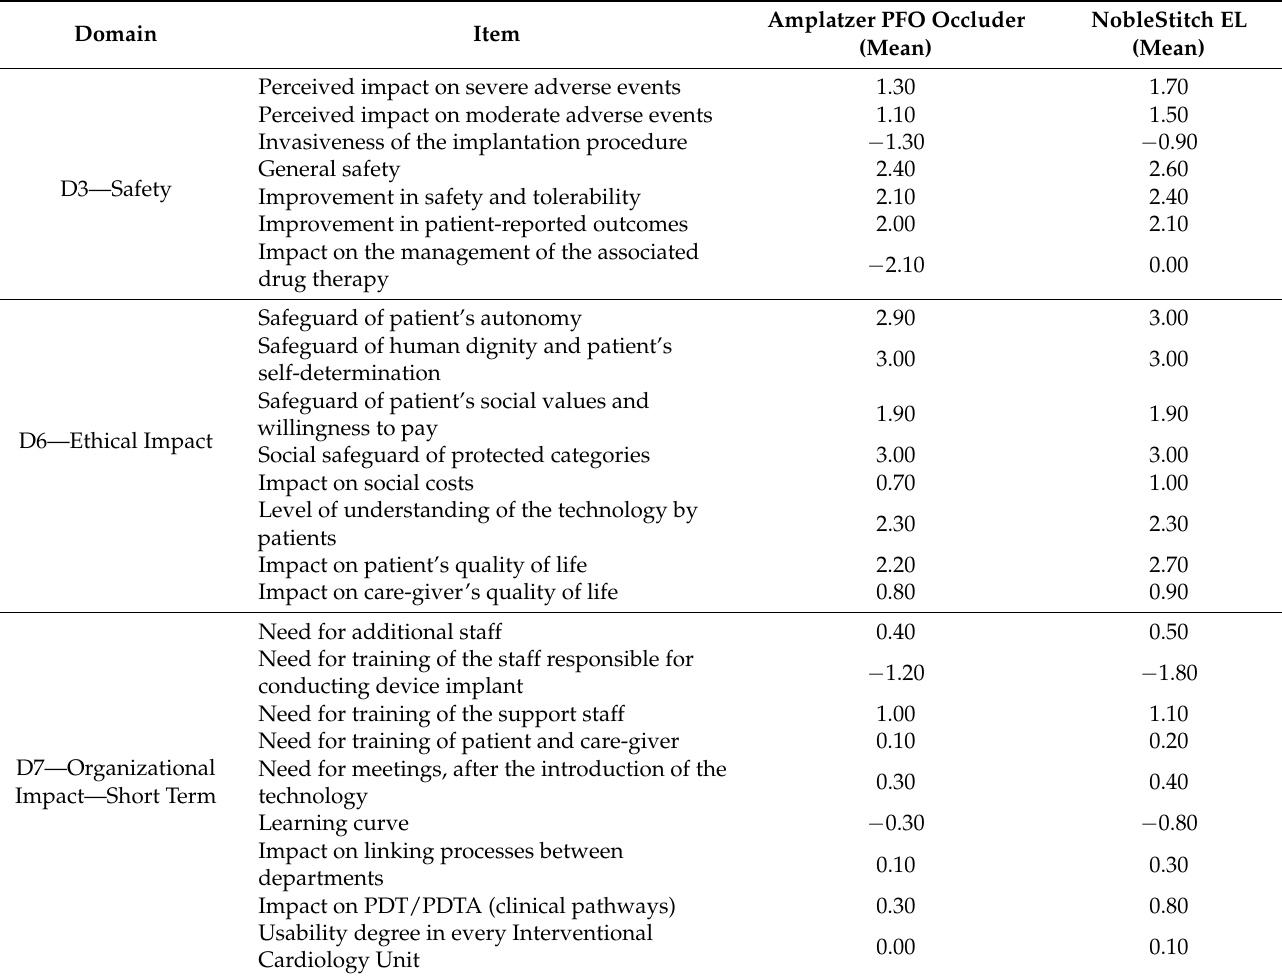
Table 4. Results from interviews with San Raffaele Hospital experts used for